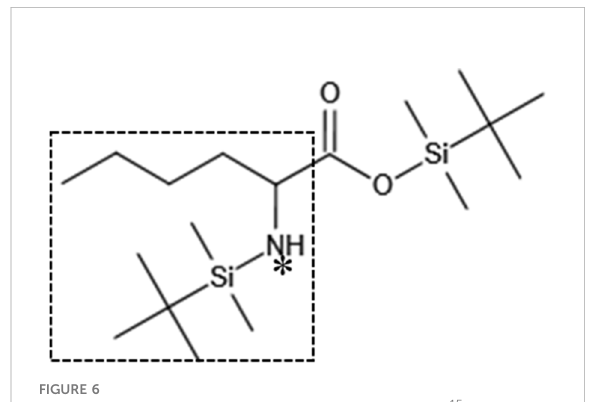
FIGURE 6 Characteristic fragment of the leucine derivative (*: 15 N labelling